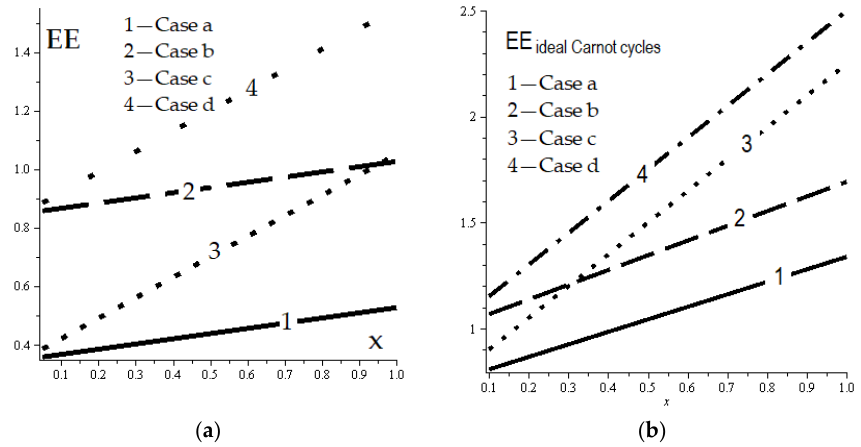
Figure 14. ( a ) The irreversible energy efficiency of trigeneration systems. ( b ) The ideal reversible energy efficiency of trigeneration systems.